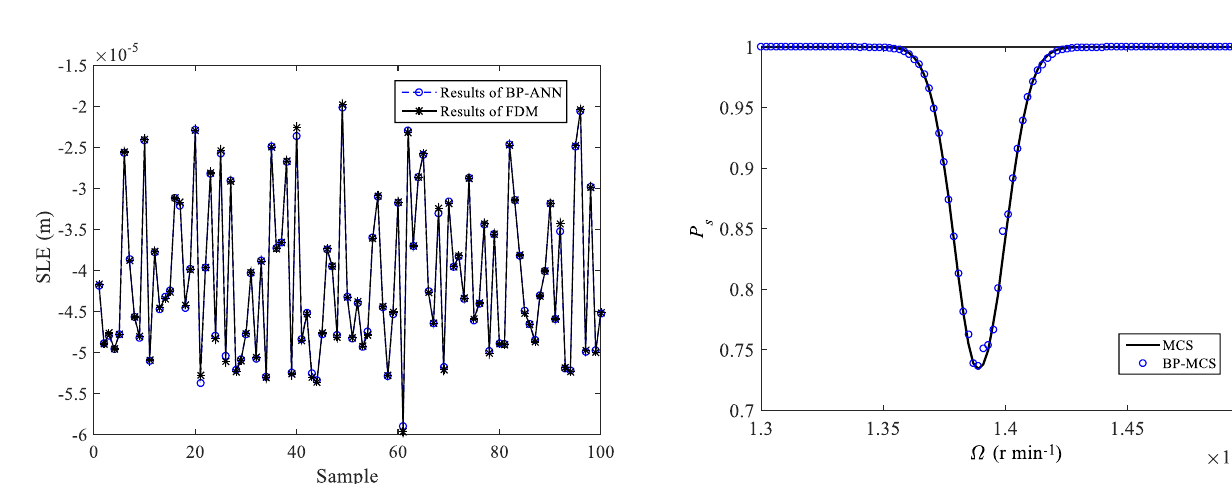
Figure 6. Comparison of BP-ANN and FDM results.